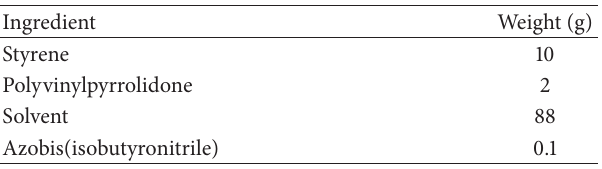
Table 1: The standard recipe for the dispersion polymerization of styrene a . Ingredient Weight (g) Styrene 10 Polyvinylpyrrolidone 2 Solvent 88 Azobis(isobutyronitrile) 0.1 a 70 ∘ C; 24h; 80r/min; 10wt% of monomer concentration based on total